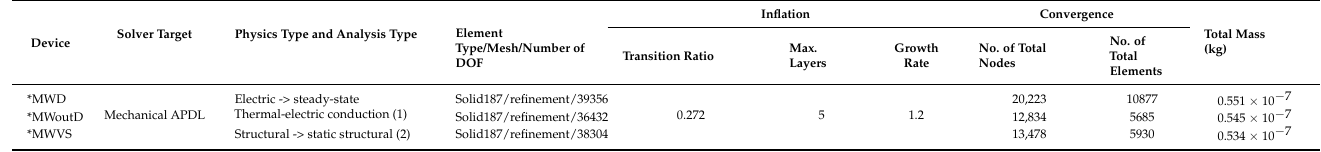
Table 9. Technical details about FEA in Ansys Workbench for microgripper simulation.